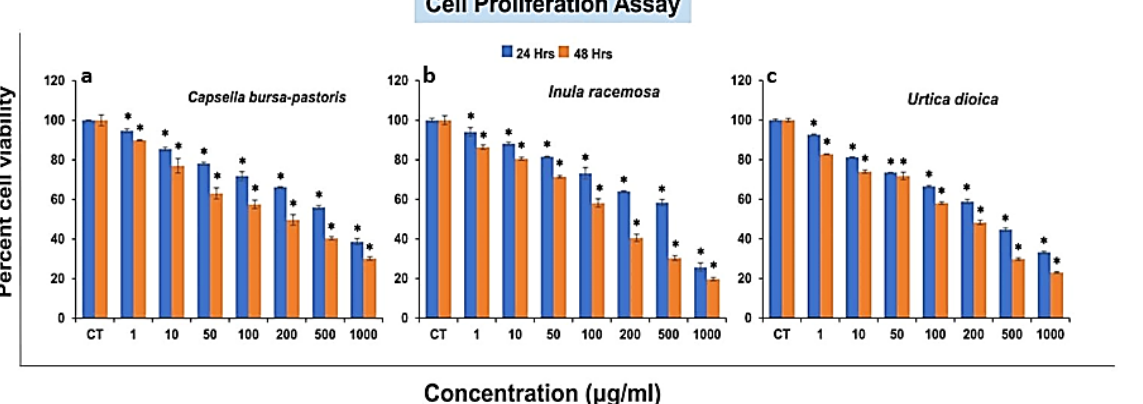
Figure 7. Effects of ( a ) whole plants of Capsella bursa-pastoris (CBP), ( b ) rhizomes of Inula racemosa (IR) and ( c ) Urtica dioica (UD) leaves on the proliferation of a liver cancer cell line (HepG2). HepG2 cells were exposed to various concentrations of drugs, and cell viability was assayed using MTT as a substrate by measuring the absorbance at 570 nm. Data are shown as the mean ± SD for n = 3. p < 0.05 was considered statistically significant. * Indicates a significant difference between the groups.